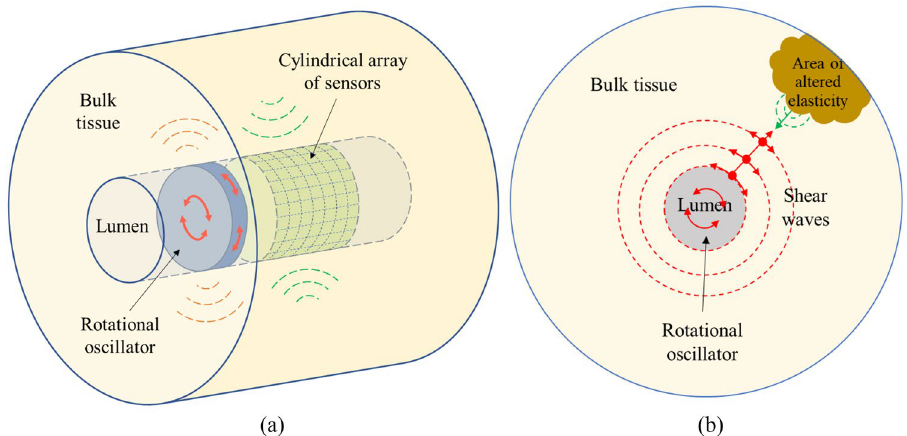
Figure 1. ( a ) Conceptual idealisation of the transluminal elastography approach. The transluminal probe, composed for at least one rotational oscillator and a cylindrical array of sensors, is inserted through the lumen. ( b ) Cross section schematic view of the transluminal approach. Shear waves propagates radially from the rotational oscillator disk emitter. Particles vibrate in an arc-shaped manner perpendicular to the propagation direction. Echoes are generated as the shear waves interact with the area of altered viscoelastic properties. Source : Gomez et al. 4